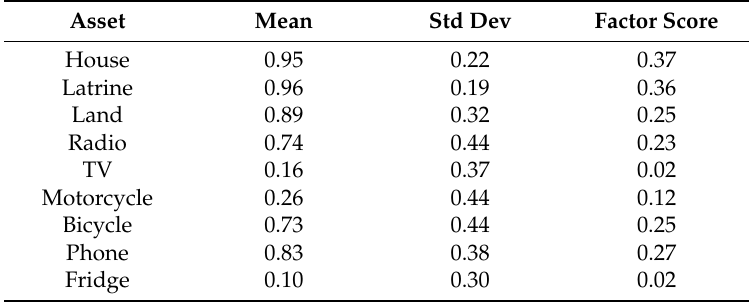
Table 4. Summary statistics and factor scores for assets included in the wealth